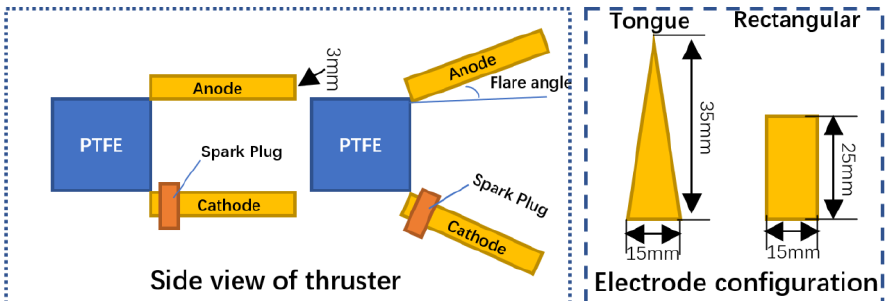
Figure 2. Schematic diagram of the electrode configuration.